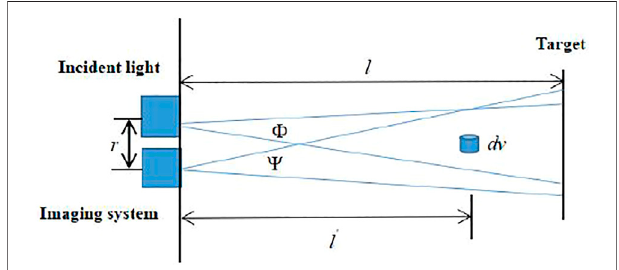
FIGURE 4 | The schematic diagram of forward scattering to underwater